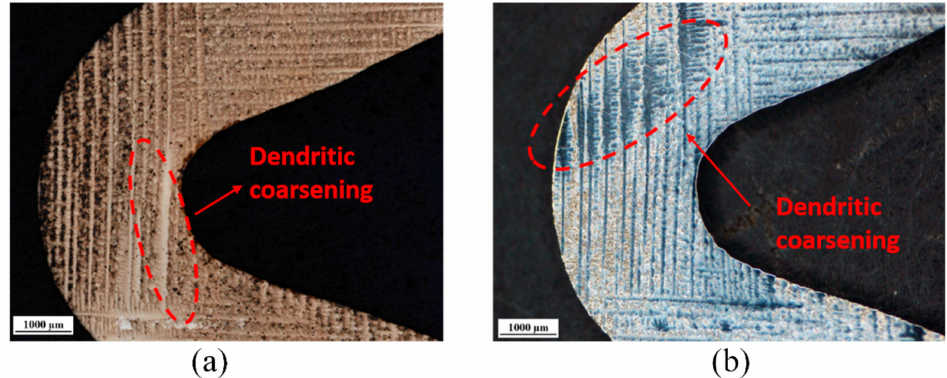
Figure 8. The dendrite coarsening occurring in the first corner ( a ) and the second corner ( b ) of the selector